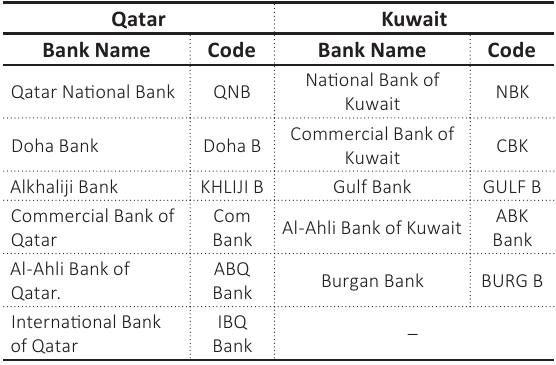
Table 1. Sample of the selected banks